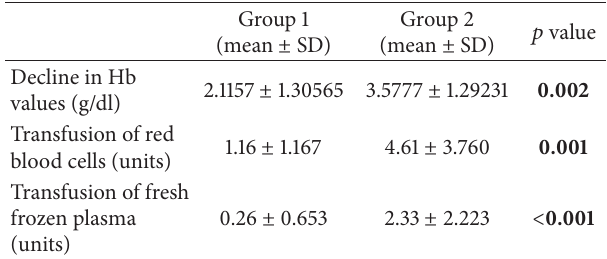
Table 1: Peripartum features of